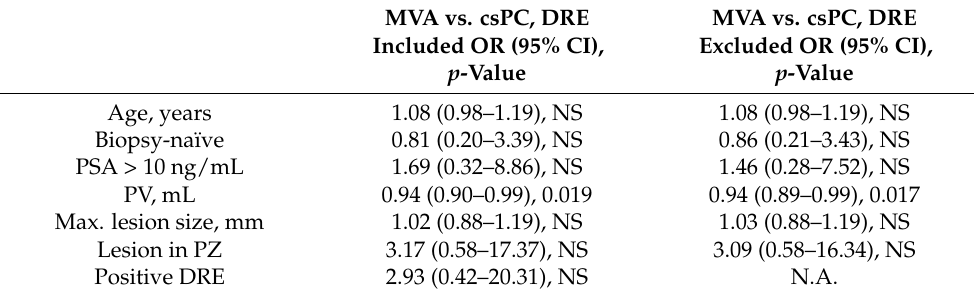
Table 4. Association between clinically significant prostate cancer (csPC) diagnosis and other factors in patients with the highest PIRADS category 3.